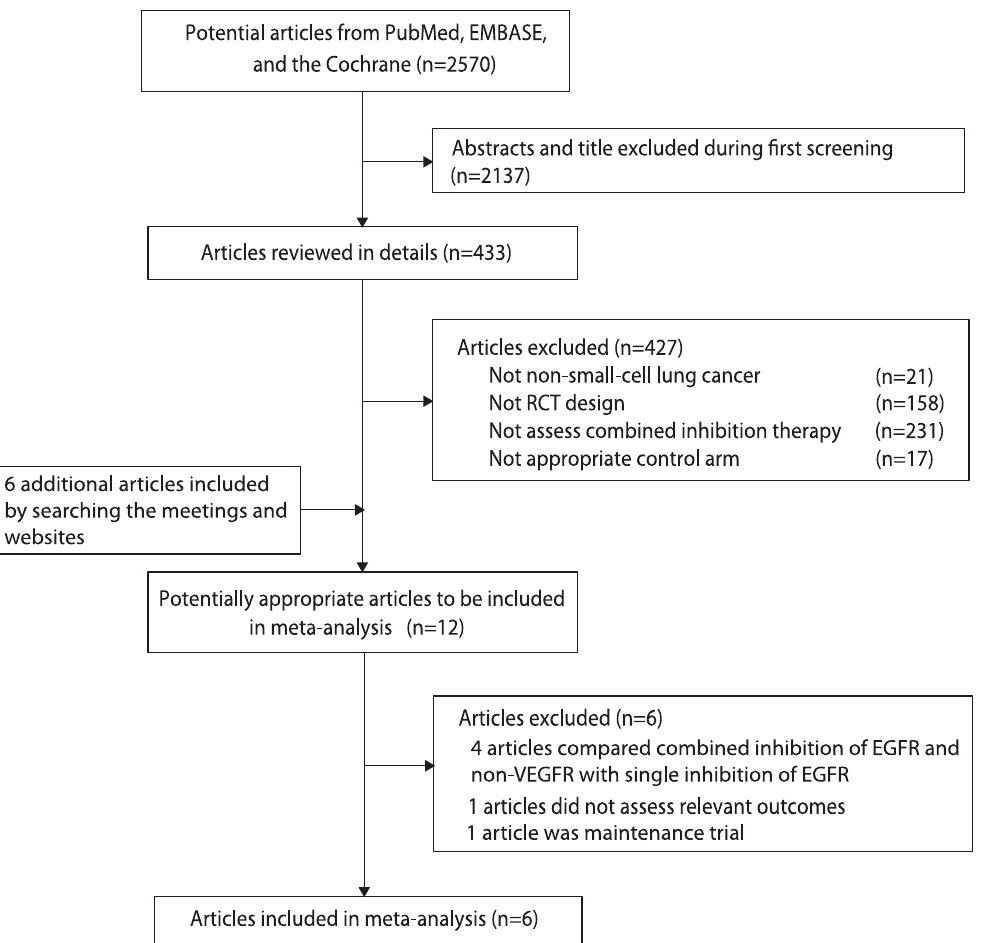
Figure 1. Identification process for eligible studies.